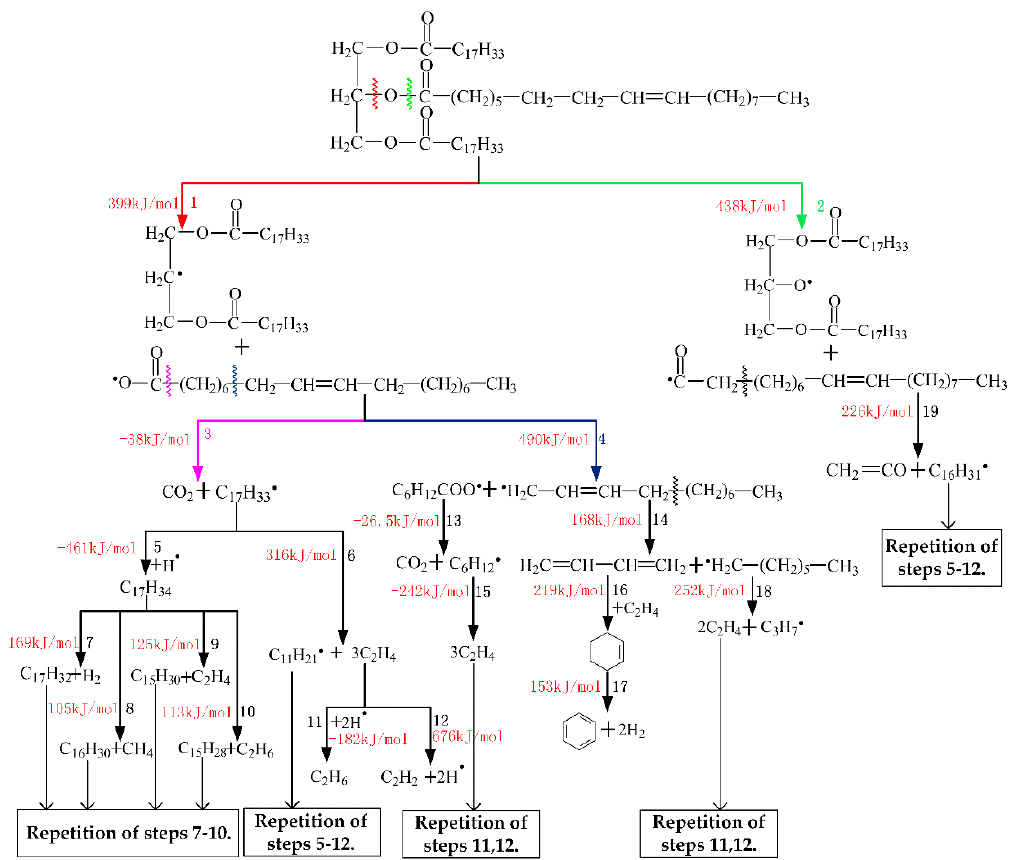
Figure 22. The principal decomposition pathways of oleic ‐ type triglyceride and their standard enthalpies of reactions calculated using M06 ‐ 2x method.